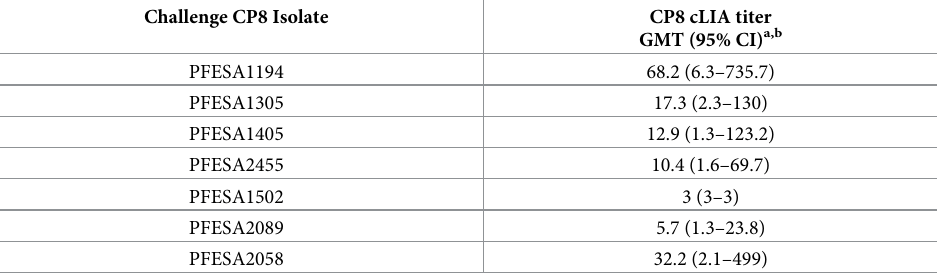
Table 5. Detection of CP5 and CP8 immune responses in mice challenged with S . aureus isolates. CP8 antibody titers in mice challenged with CP8 S . aureus isolates. A panel of seven different CP8 isolates representing different com- binatins of in vitro and in vivo CP8 expression were used to challenge mice; five CC12 isolates (PFESA1194 ( in vitro +, in vivo +), PFESA1305 (–, +), PFESA1405 (–, +), PFESA2455 (–, +), PFESA1502 (–,–)) and two CC188 isolates (PFESA2089 (+, not tested in vivo ), PFESA2058 (–, +)). CD1 mice (7–9 weeks of age, 10 per group) were administered three IP injections of ~ 2x10 6 CFU/animal in 0.5 mL at 0, 4 and 12 weeks and bled at week 27. CP8 antibody responses were measured using a CP8 specific cLIA assay. CP8 antibody responses were detected in mice infected with all isolates except the CC12-t160 isolate (PFESA1502) that didn’t express capsule in the IFA murine model. Challenge CP8